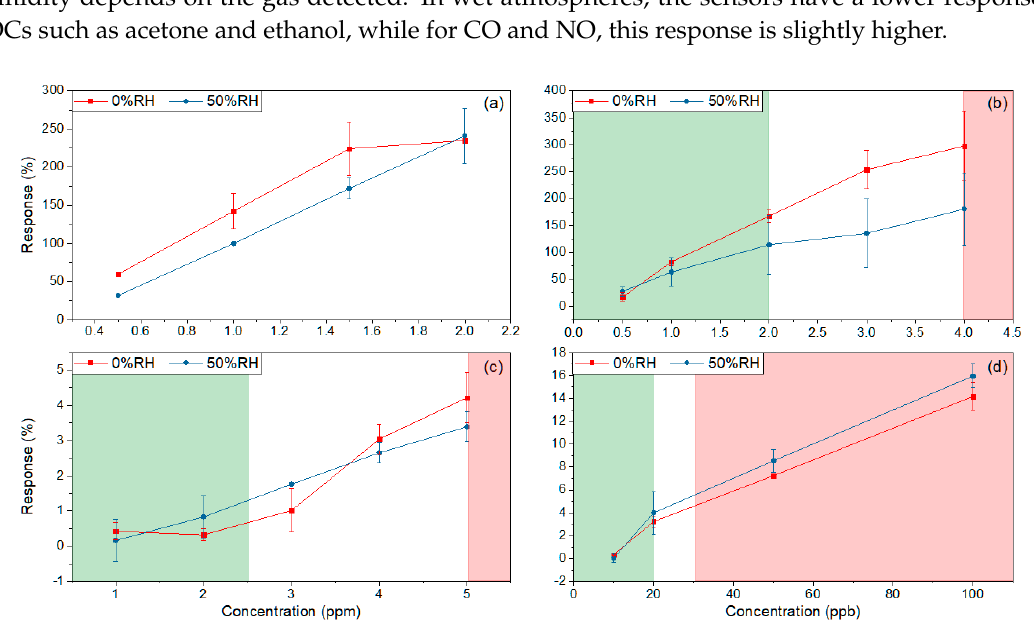
Figure 6. Responses at 300 ◦ C in dry (0% RH) and humidity (50% RH) air to di ff erent concentrations of biomarkers: ( a ) ethanol; ( b ) acetone; ( c ) CO; ( d ) NO. The green and red shades represent the concentrations corresponding to healthy and sick people,